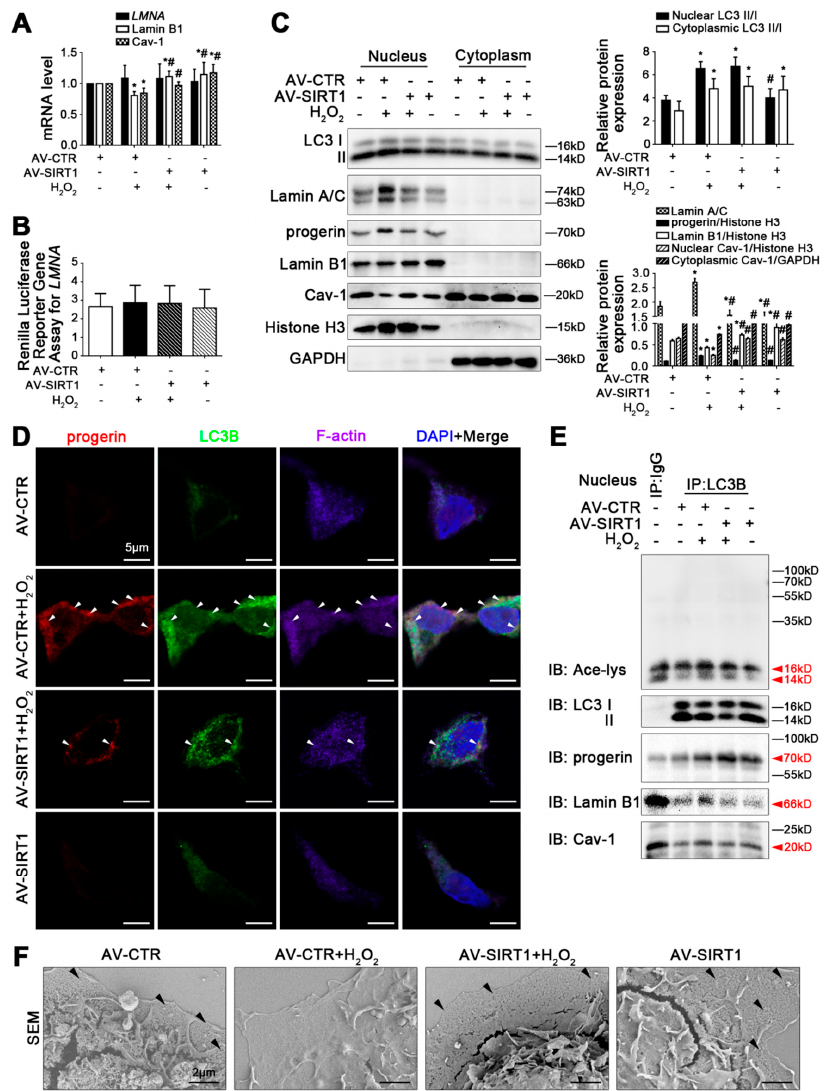
Figure 7. Overexpression of SIRT1 promotes progerin nucleophagic degradation via deacetylation of nuclear LC3 and inhibits loss of Lamin B1 and Cav-1, contributing to maintaining LSEC fenestrae. Fresh rat primary LSECs were transfected with SIRT1 adenovirus vector (called AV-SIRT1) to overex- press SIRT1 or nontarget adenovirus vector (called AV-CTR) and then stimulated with H 2 O 2 (10 µ M) for 48 h. ( A ) RT-qPCR analysis for mRNA levels of LMNA , Lamin B1, and Cav-1 of primary LSECs in the four groups (AV-CTR, AV-CTR+H 2 O 2 , AV-SIRT1+H 2 O 2 , AV-SIRT1). * p < 0.05 versus the AV-CTR group; # p < 0.05 versus the AV-CTR+H 2 O 2 group. ( B ) Renilla Luciferase Reporter Gene Assay for LMNA promoter activity of primary LSECs in the four groups. ( C ) Representative immunoblots of LC3 II/I, Lamin A/C, progerin, Lamin B1, and Cav-1 in nucleus and cytoplasm of primary LSECs in the four groups. The relative protein expression and LC3 II/I expression in nucleus and cytoplasm are quantified in the two graphs (right). * p < 0.05 versus the AV-CTR group; # p < 0.05 versus the AV-CTR+H 2 O 2 group. ( D ) The immunocytochemical co-localization of progerin (red) with LC3B (green) and F-actin (purple) of primary LSECs in the four groups (scale bar: 5 µ m). Nucleus is shown by DAPI (blue). ( E ) The interaction of nuclear LC3B with acetyl Lysine, progerin, Lamin B1, and Cav-1 was detected by the co-IP assay. Nuclear LC3B in primary LSECs was individually immuno- precipitated, and subsequently, acetyl Lysine, progerin, Lamin B1, Cav-1 and LC3 II/I in nucleus of LSECs in the four groups were subjected to immunoblotting analysis. ( F ) The magnification of SEM for fenestrae in primary LSECs in the four groups (scale bar: 2 µ m). The black triangles indicate fenestrae in